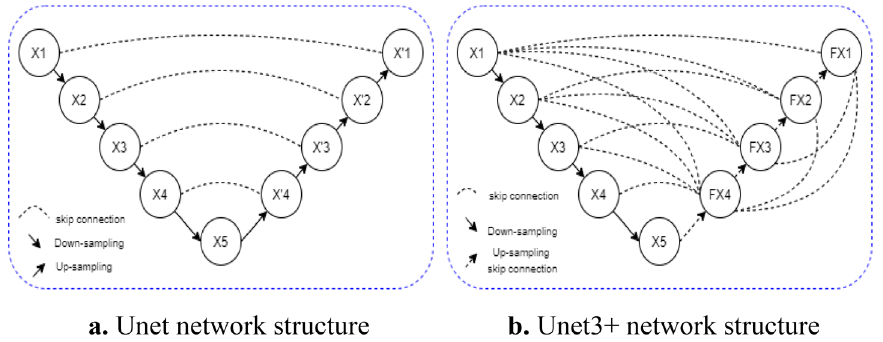
Figure 1. Schematic diagram of Unet and Unet3+ network structure.